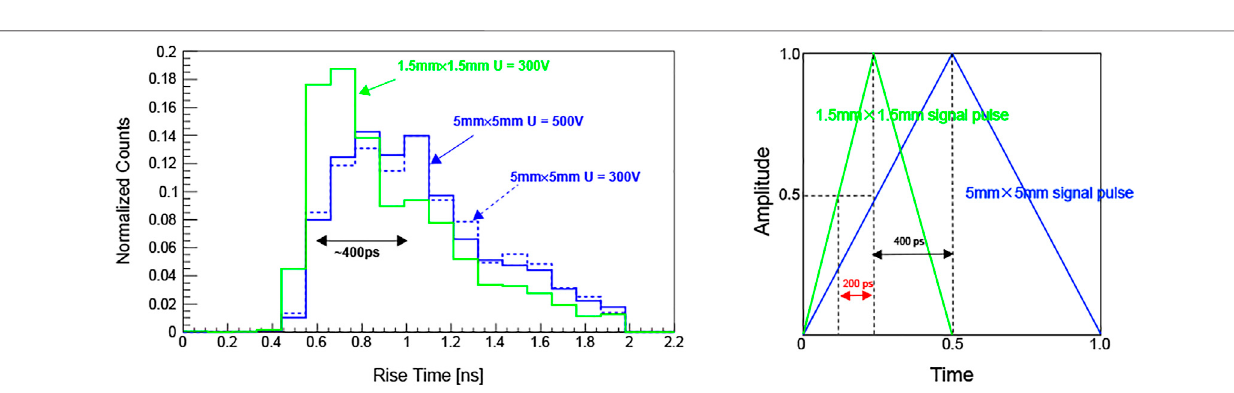
Frontiers in Physics |